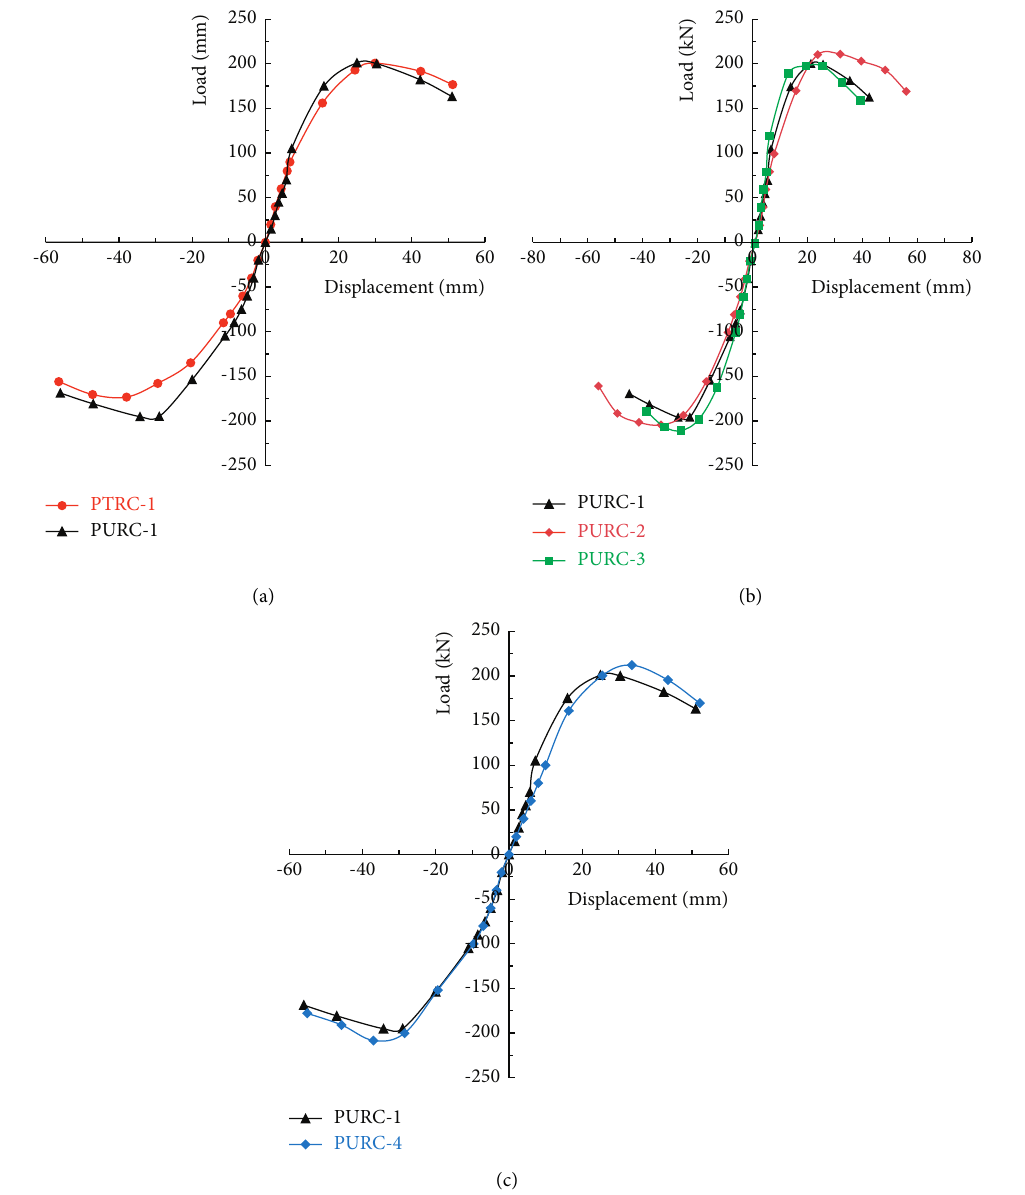
Figure 6: Skeleton curves of specimens. (a) PTRC-1 and PURC-1. (b) PURC-1, PURC-2, and PURC-3. (c) PURC-1 and